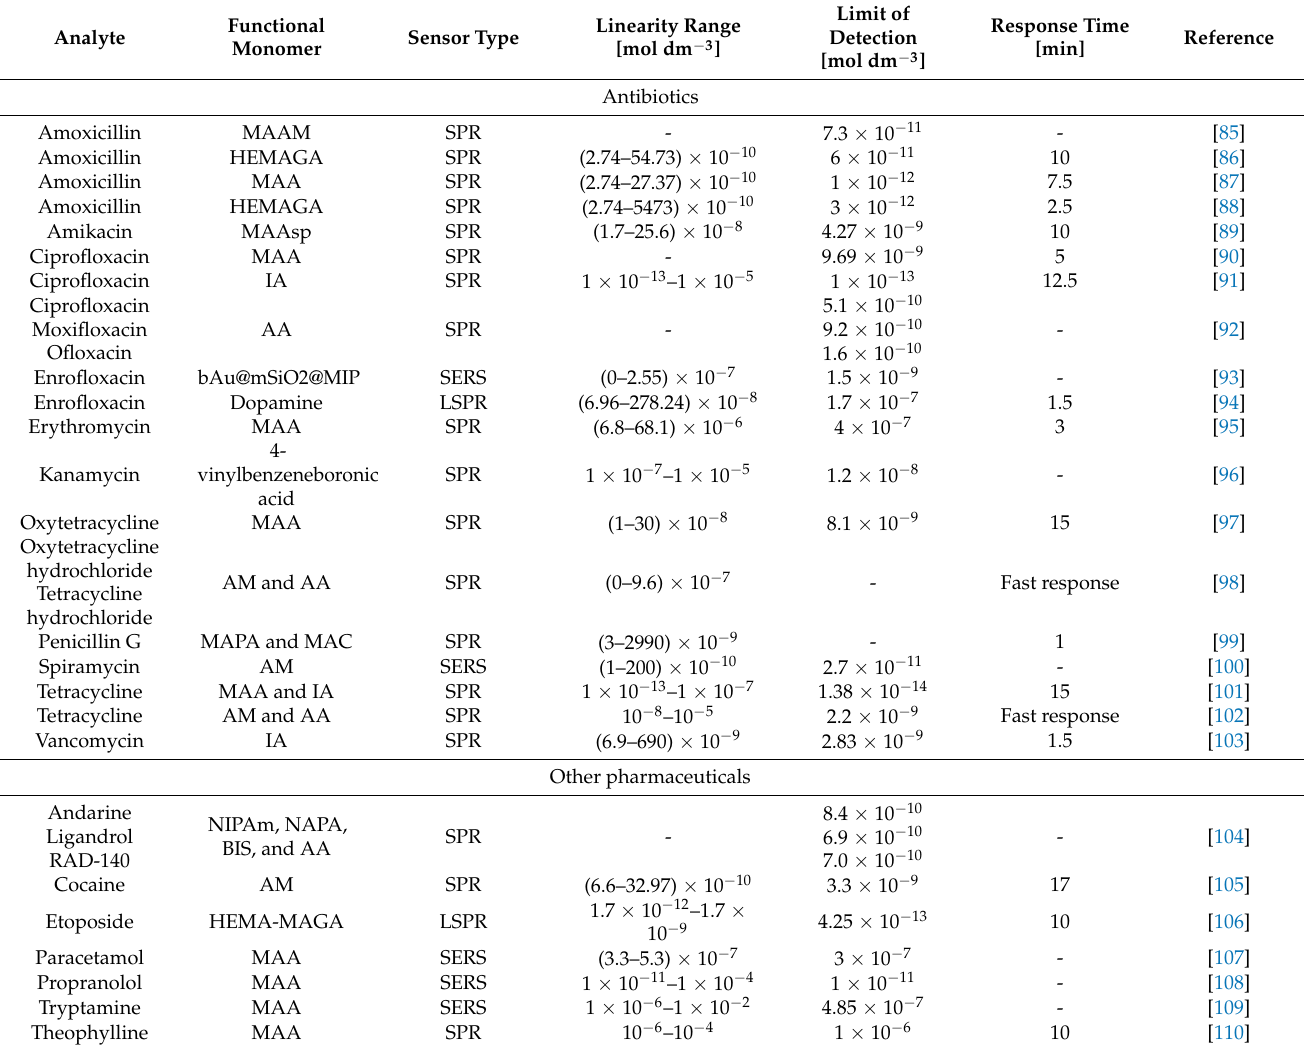
Table 2. MIP-based plasmonic sensors for pharmaceutical detection and their most important